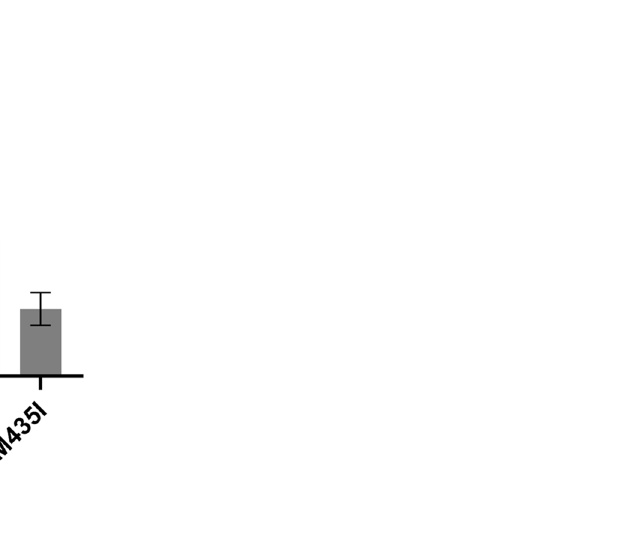
Figure 2. Uptake of 14 C-labelled xylose by selected Gal2 variants. Gal2 wildtype (WT) and indicated mutants were expressed in the hxt 0 strain EBY.VW4000 and the uptake velocity was measured at 500 mM total xylose. The uptake velocity is shown as nmol xylose taken up per minute per mg cell dry weight (nmol min −1 mg CDW−1 ). Mean values and standard deviation of triplicate measurements are